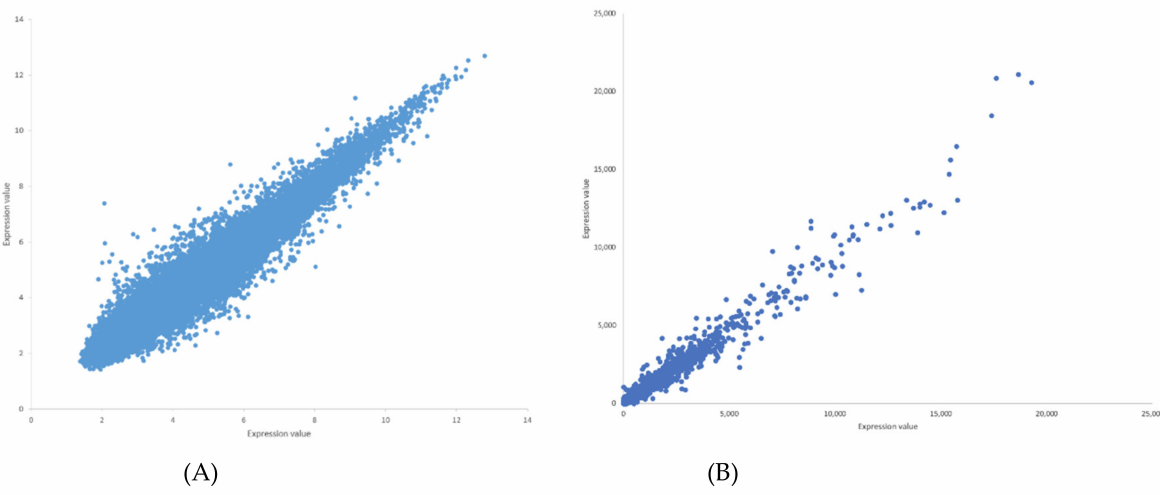
Figure 2. ( A ) Plot of gene expression values for Arabidopsis thaliana WS root growth in spaceflight microgravity from GLDS-7 dataset. The plot shows high correlation between the first column ( x -axis) and second column ( y -axis) of gene expression values for 20,000 genes. ( B ) Plot of gene expression values for Arabidopsis thaliana Col-0 root growth in spaceflight microgravity from GLDS-120 dataset. The plot shows high correlation between the first column ( x -axis) and second column ( y -axis) of gene expression values for 20,000